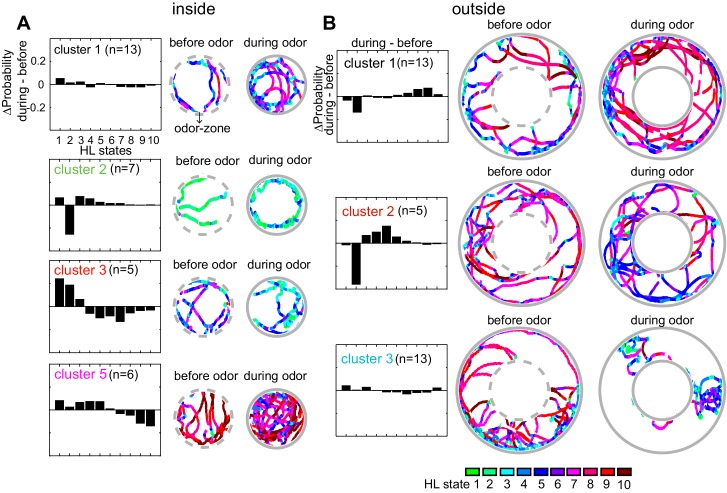
Flies’ response to odors cluster into a small number of distinct, sometimes opposing response-types.(A) The difference between HL state distributions (during-before) and tracks from an exemplar fly from each cluster is shown. Dotted grey circle indicates the odor-zone. (B) Same as A, but for odor-evoked changes outside the odor-zone.